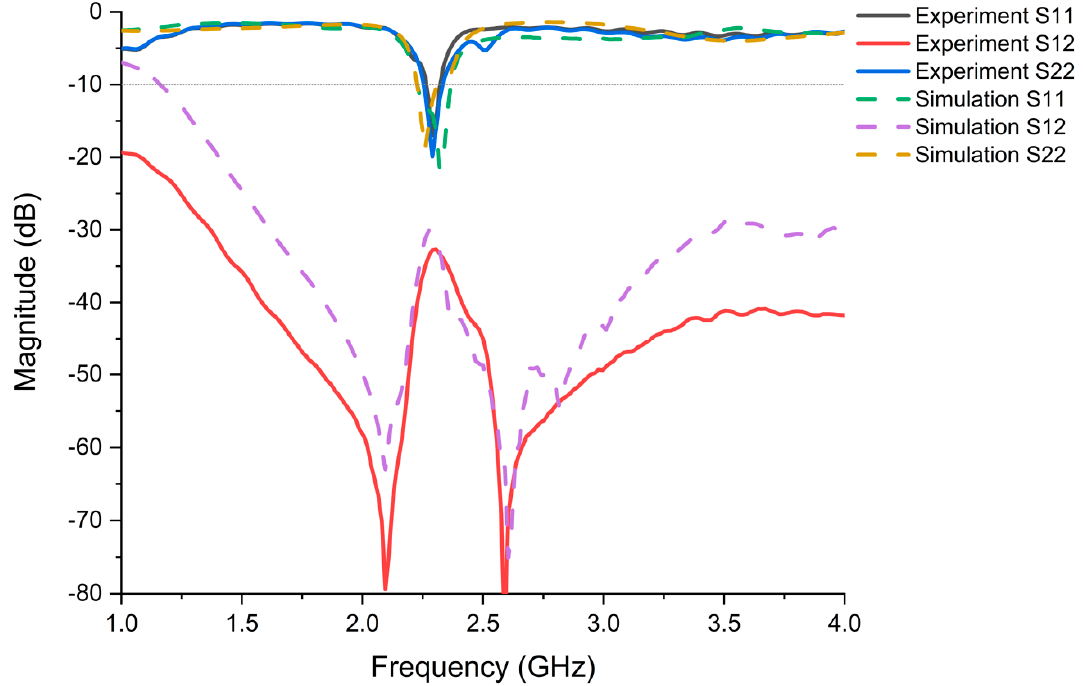
Figure 6. Simulated and measured S-parameters of the proposed full-duplex textile antenna with the combination structure (two layers of nonwoven fabric and six layers of knit fabric spray coated with BT dielectric ink). Experimental data are represented by solid curves, while simulation data are represented by dotted curves.